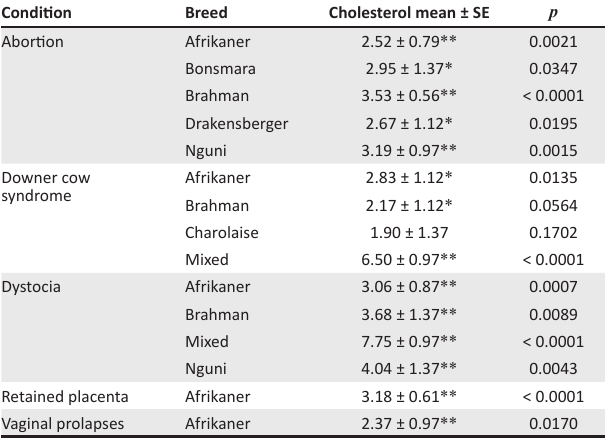
TABLE 5: Mean serum cholesterol concentrations in cows experiencing reproductive conditions in different breeds. Condition